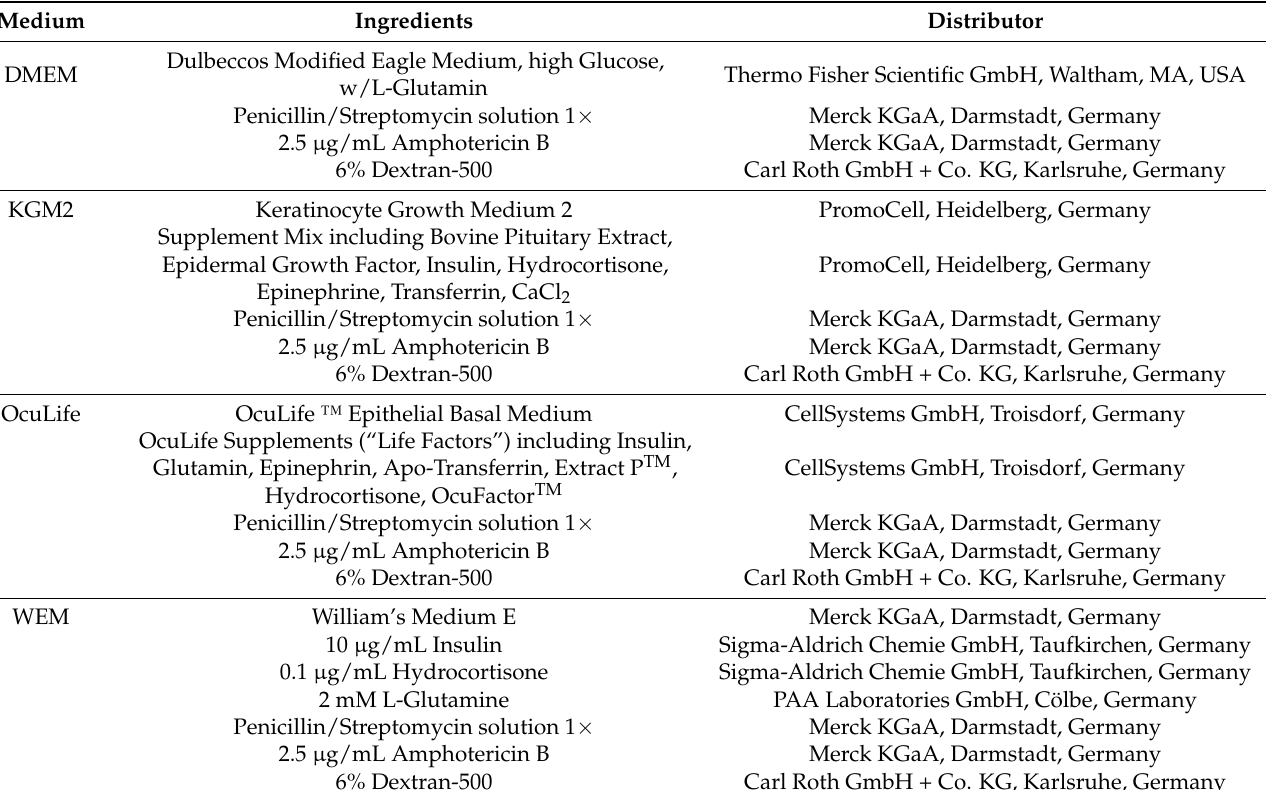
Table 1. Composition of culture media for corneal ex vivo cultivation.